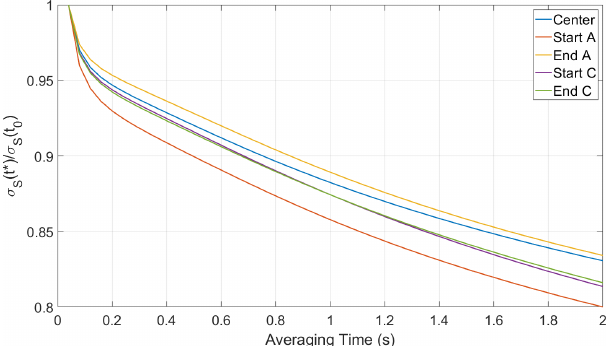
Figure A3. The time-averaged σ S (t ∗ ) normalized by σ S (t 0 ) (the standard deviation of the raw saturation ratio time series). Over the time averaging of the sonic temperature sensor, σ S decreases to ≈ 87% σ S (t 0 )